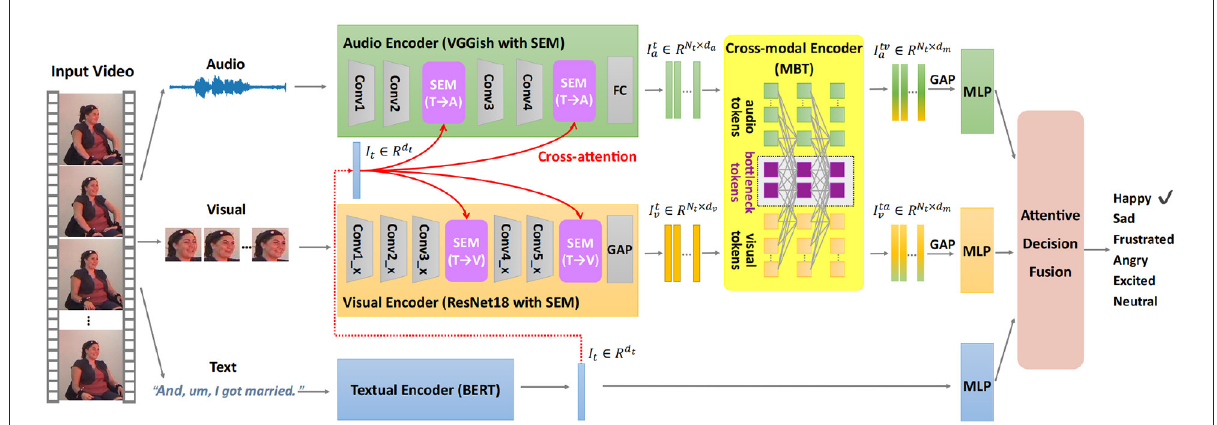
FIGURE1 The proposed end-to-end multimodal emotion recognition (MER) framework with the semantic enhancement module (SEM) and multimodal bottleneck Transformer (MBT), is denoted as MER-SEM-MBT. Given a facial video clip, the global semantic feature is first extracted through the textual encoder, which is used to guide the audio and visual representation learning through the semantic enhancement module. Then the cross-modal encoder is adopted to reinforce audio and visual representations through temporal cross-modal interaction via a multimodal bottleneck Transformer. Lastly, three separate multi-layer perceptrons (MLPs) are implemented to get unimodal decisions from audio, visual, and text modalities, respectively. Attentive fusion is performed to aggregate these decisions for final emotion prediction. The example facial video is from IEMOCAP dataset (Busso et al.,